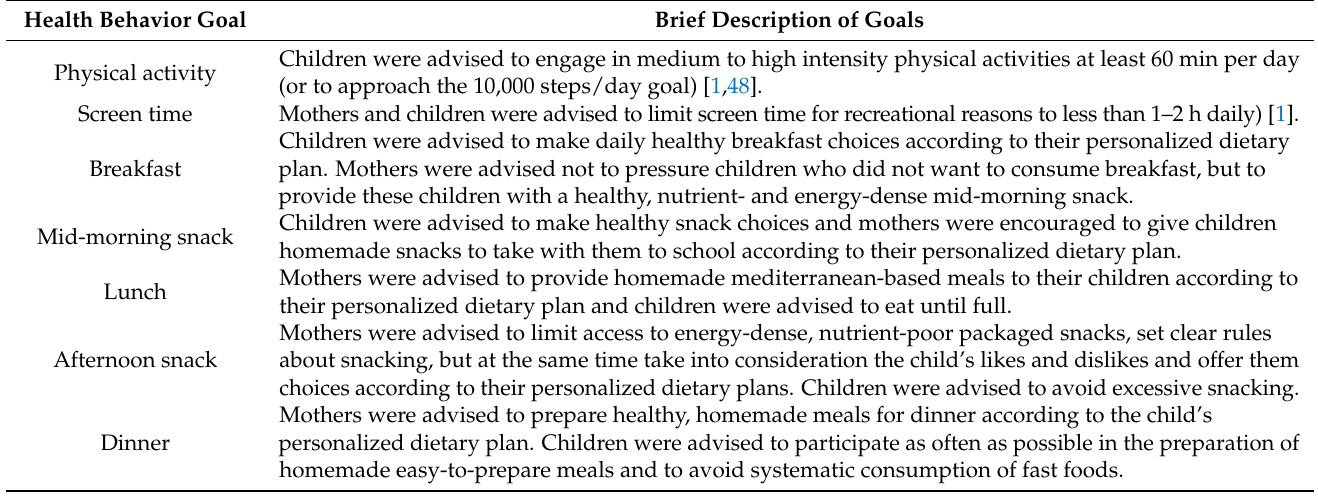
Table 1. The ENDORSE health behavior goals. Health Behavior Goal Brief Description of